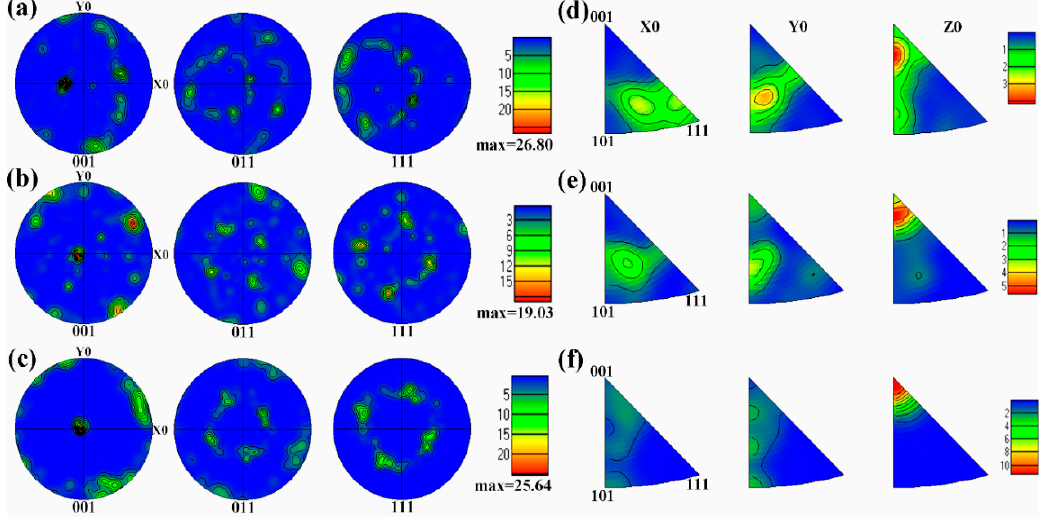
Figure 10. EBSD pole figure and inverse pole figure of Ti-26Nb samples: ( a ) and ( d ) as-deposited Ti–26Nb alloy; ( b ) and ( e ) after annealing at 650 ◦ C; ( c ) and ( f ) after annealing at 850 ◦ C. The effects of annealing temperature on the columnar grain size of the alloy were also investigated.